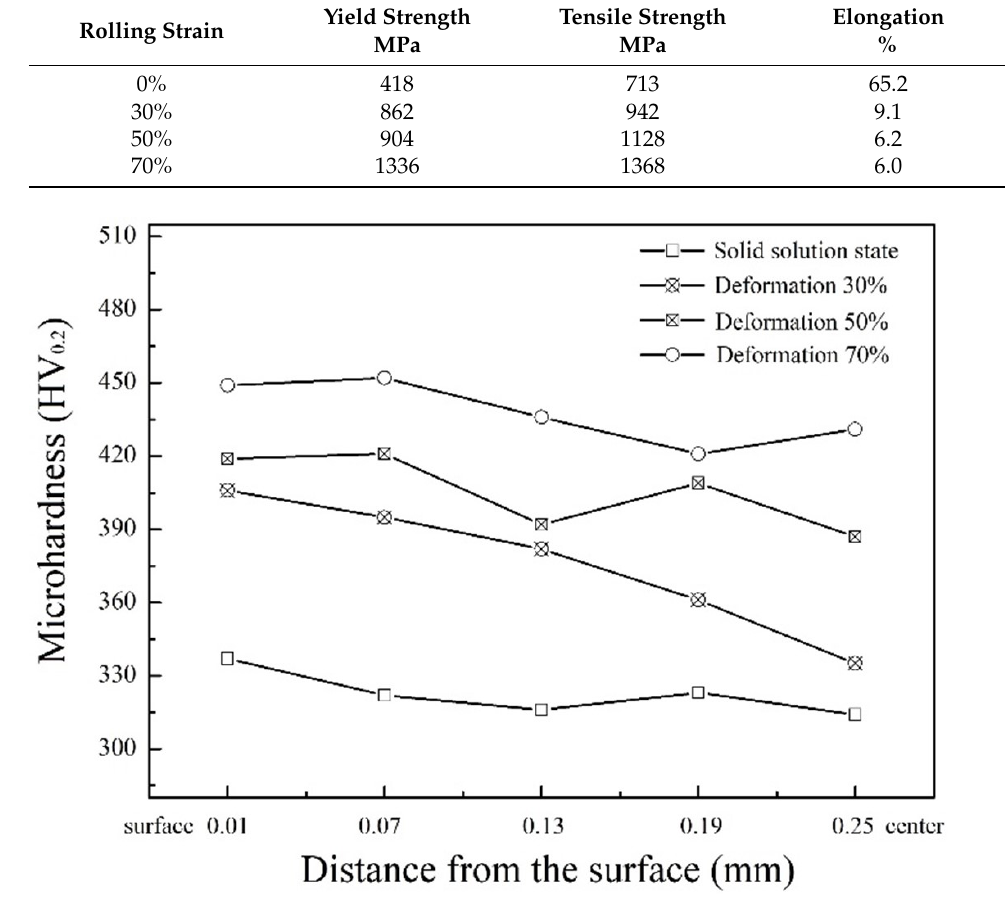
Figure 6. Microhardness distributions along the thickness direction of cold-rolled sheets with dif- ferent strains. Table 2. Mechanical properties of Fe-25Mn-3Si-3Al-0.3Nb steel before and after cold rolling.